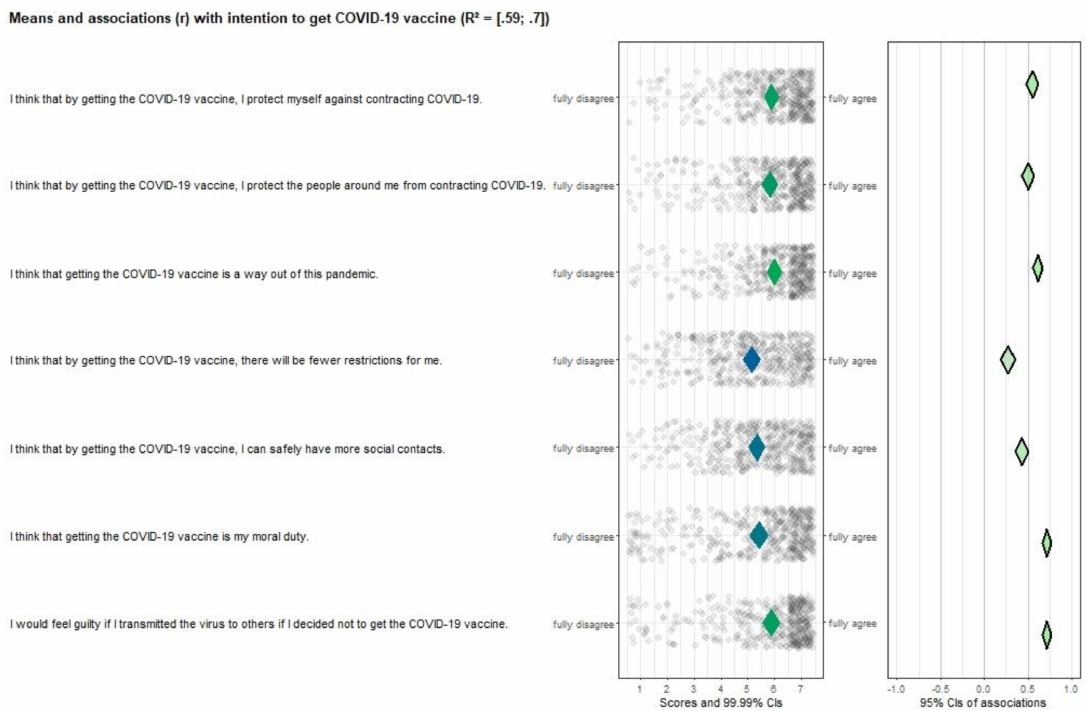
Figure 3. CIBER plot of attitude visualizing means and association with intention to get the COVID-19